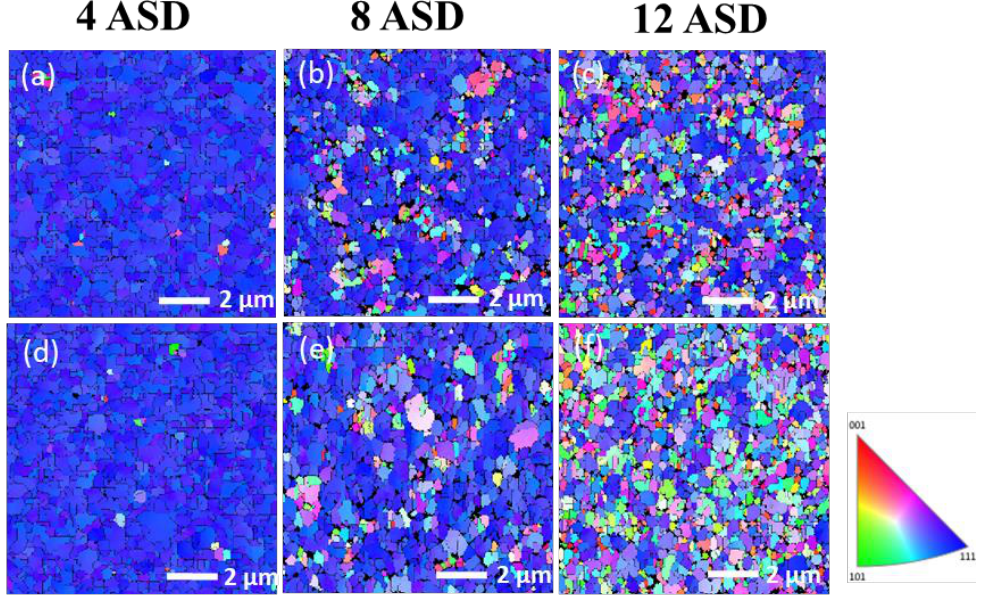
Figure 2. Top-view EBSD images of the as-fabricated ( a – c ) and annealed ( d – f ) nt-Cu films deposited with various current densities of 4, 8, and 12 ASD, respectively. The nt-Cu films were electrodeposited at 25 ◦ C and the annealing was conducted at 200 ◦ C for 10 h. Table 1. Degree of (111) orientation and grain size of the films deposited at 25 ◦ C. Samples